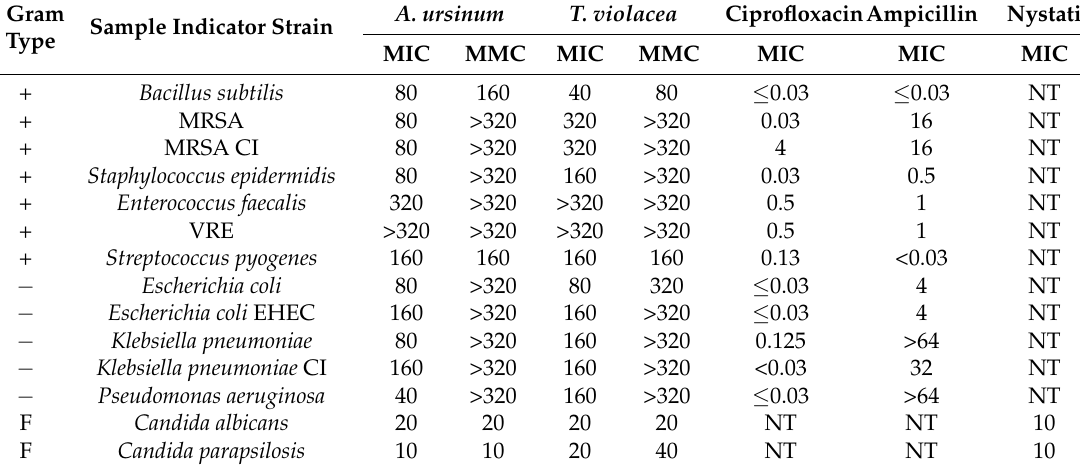
Table 3. Antimicrobial activity of Allium ursinum ( A. ursinum ) and Tulbaghia violacea ( T. violacea ) extracts against different G-positive and G-negative bacteria and Candida yeasts. MIC (minimum inhibitory concentration) and MMC (minimum microbicidal concentration) values are shown as µ g/mL. Positive controls are ciprofloxacin, ampicillin, and nystatin.